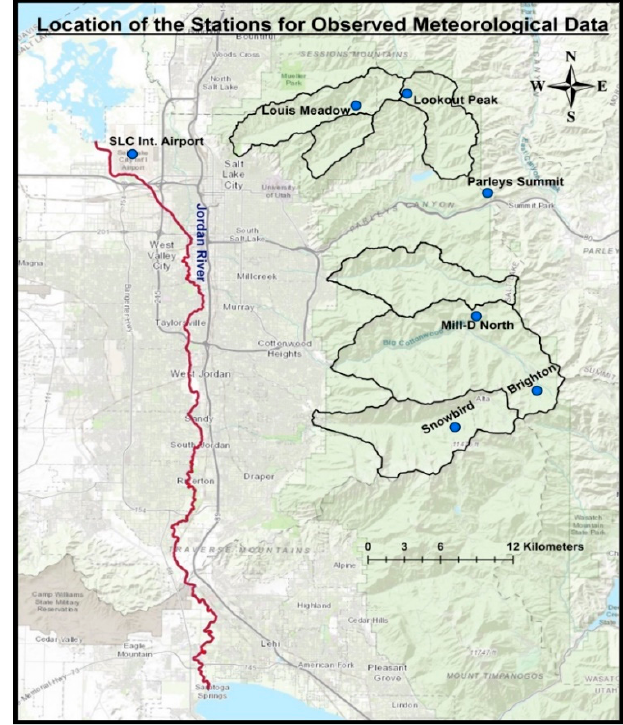
Figure 3. Locations of SNOTEL stations used for observed meteorological data .